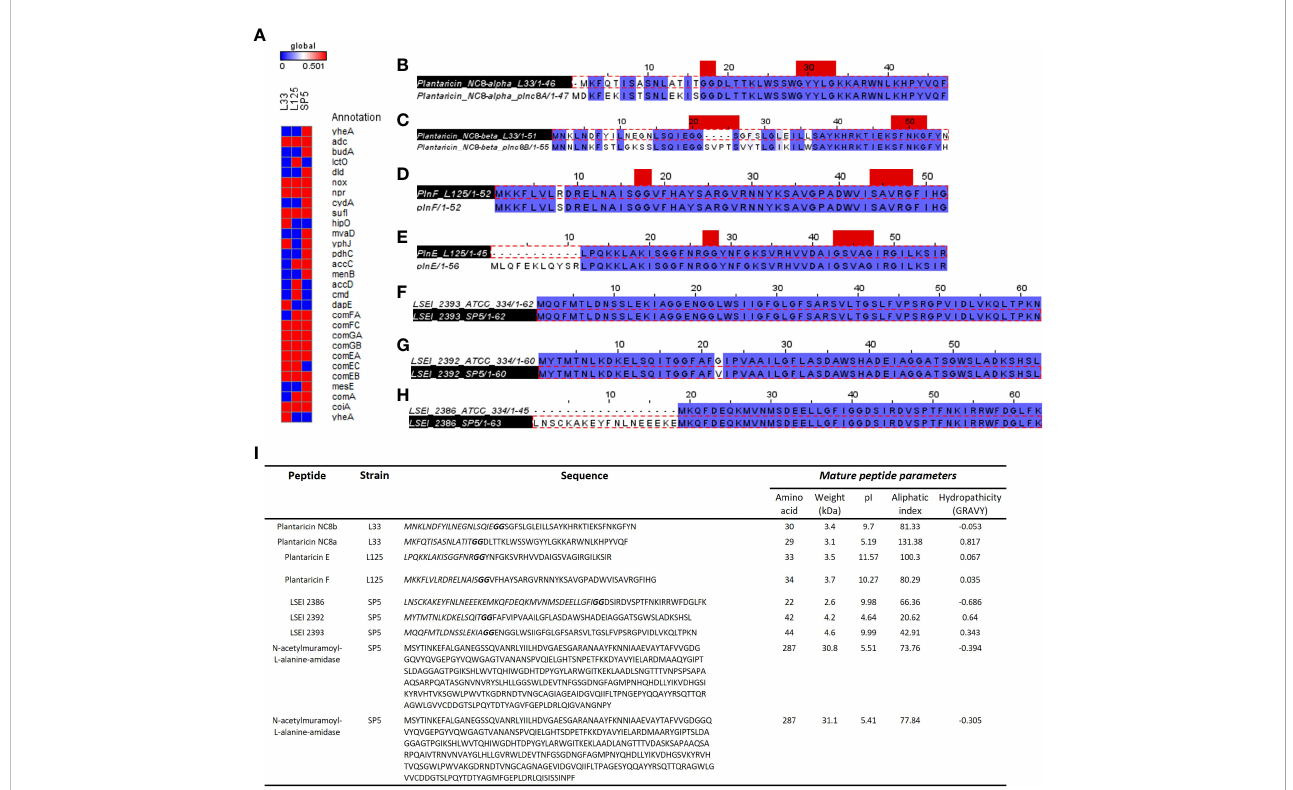
FIGURE 9 Annotation of genes and gene clusters involved in the antimicrobial capacity of the tested lactobacilli. (A) Presence/absence matrix including genes involved in the production of secondary metabolites, lactic acid, ethanol, and hydrogen peroxide presenting antimicrobial activity, as well as genes included in competency clusters ( Com F, Com G, Com E). Annotation of WGS was performed in the KEGG database. (B – H) Sequence alignment of putative bacteriocin pro-peptides identi fi ed in the genome of (B, C) Lp. pentosus L33, (D, E) Lp. plantarum L125 and (F – H) Lc. paracasei SP5 with homologous bacteriocins of closely related strains. The GG cleavage motif and the GxxxG or SxxxG dimerization motifs are denoted in red. The alignments were performed with ClustalW and Jalview was utilized for the visualization of results. (I) Table presenting the sequences of putative bacteriocins identi fi ed in WGS of strains using BAGEL4 and Blastp+. The GG motif is highlighted in bold, and the N-terminal signal sequence in italics. The physicochemical properties of the putative peptides were determined using